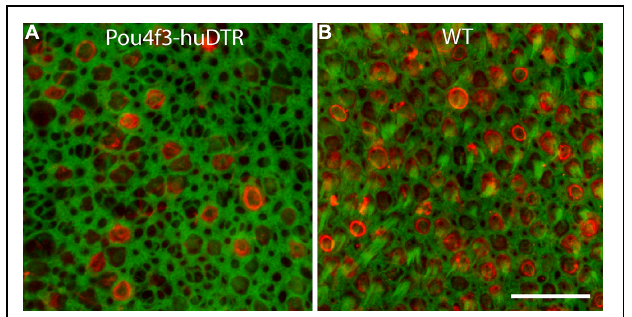
FIGURE 2 | Changes in the structure of actin bundles at cell–cell junctions following DT-mediated hair cell loss. All specimens were stained with phalloidin (red), which labels filamentous actin. (A) Junctions in undamaged utricles of control mice were comprised of thick actin bundles. Numerous stereocilia bundles were also apparent. (B) At 7 days after DT-induced hair cell injury, the epithelia contained many thin actin fibers, which are likely to be loci of epithelial repair after hair cell loss. Structures of thinner actin usually occupied a single cell-width (arrows), but some structures appeared to extend for several cell widths (arrow head). (C) Sensory epithelia of utricles examined at 56 days recovery from hair cell lesions contained very thick actin cables, suggesting nearly complete repair of the lumen. Scale bar = 10 µ